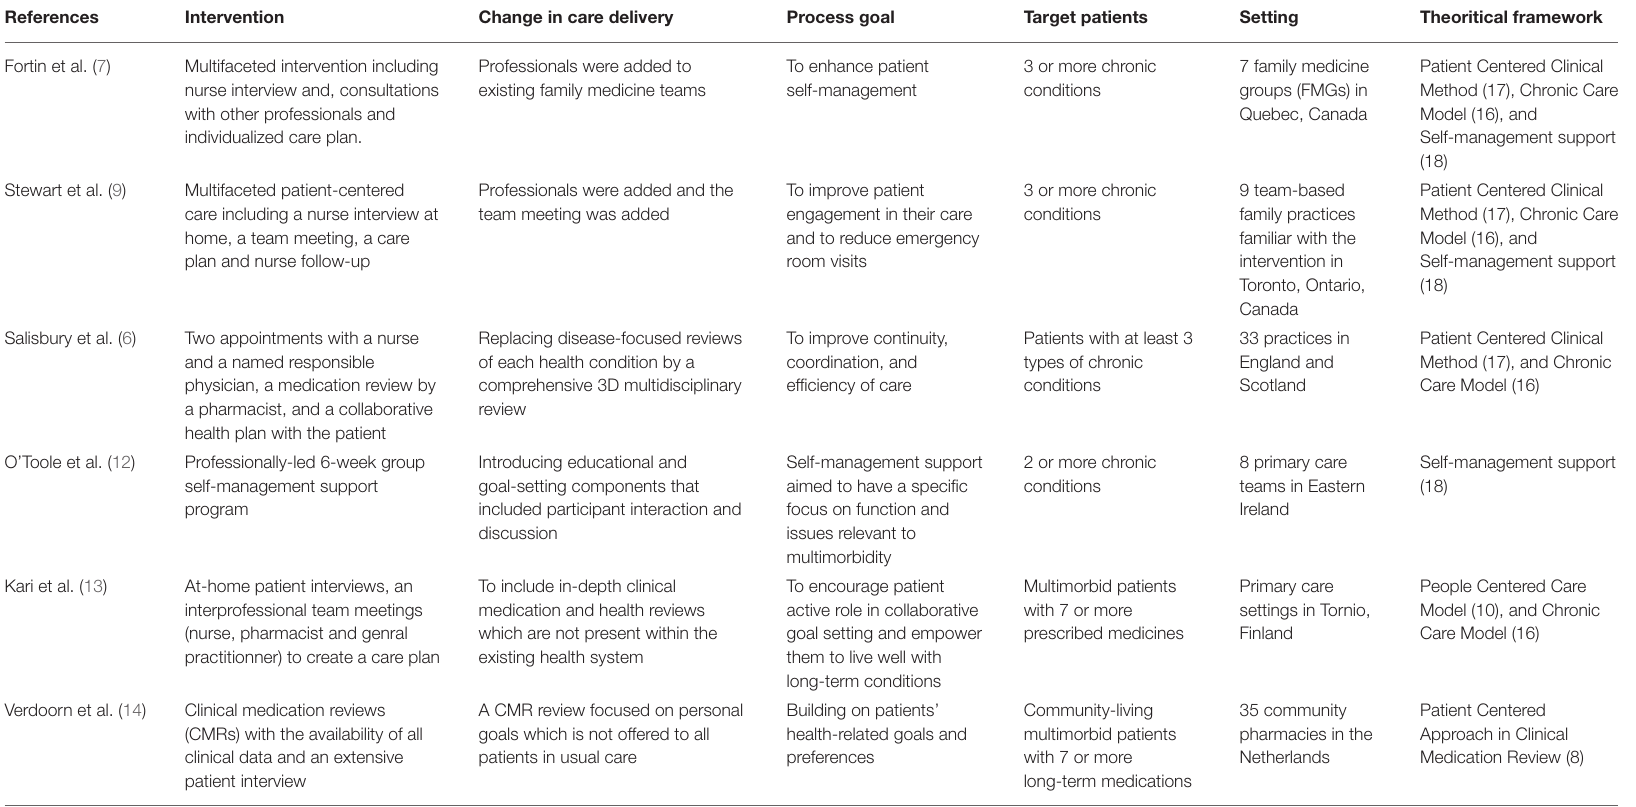
TABLE 2 | Description of included